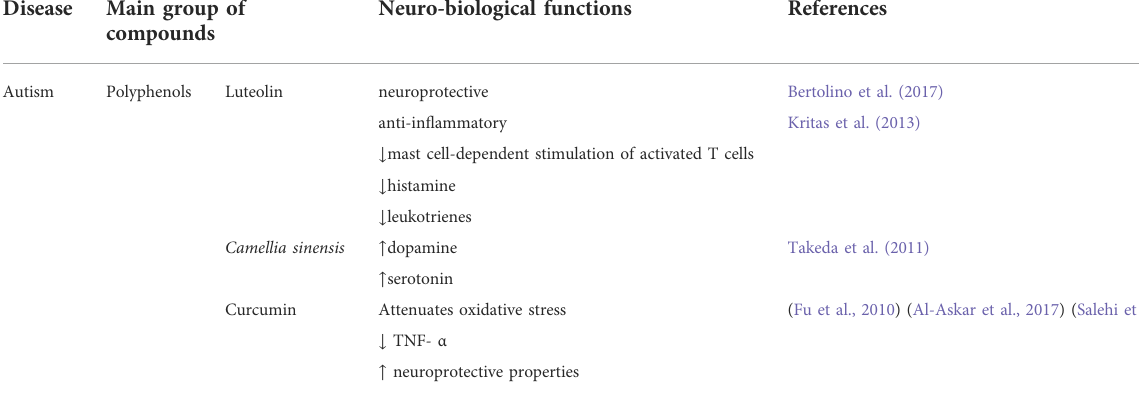
TABLE 5 Natural products used in the treatment of autism.